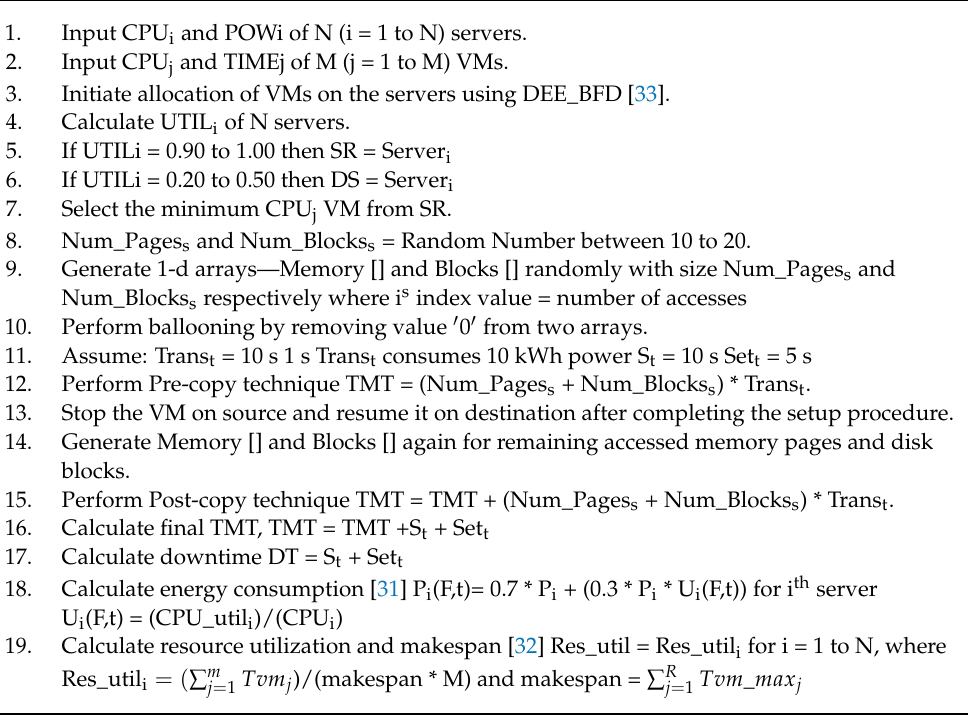
Algorithm 1. Live migration with ballooning (LMB)